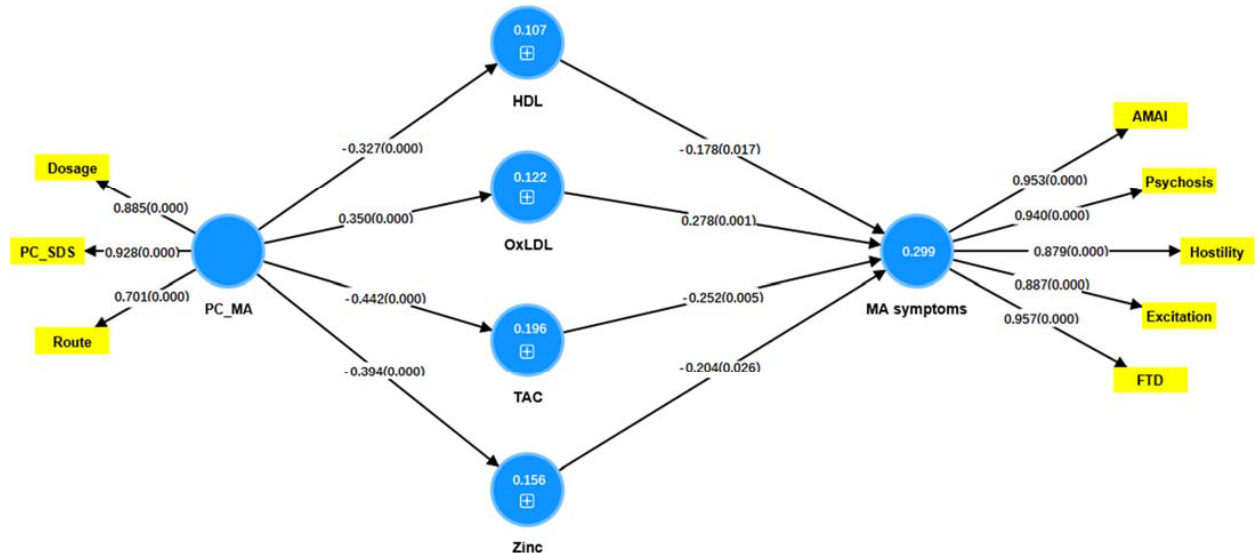
Figure 6. The results of the Partial Least Squares (PLS) analysis which show the impact of metham-